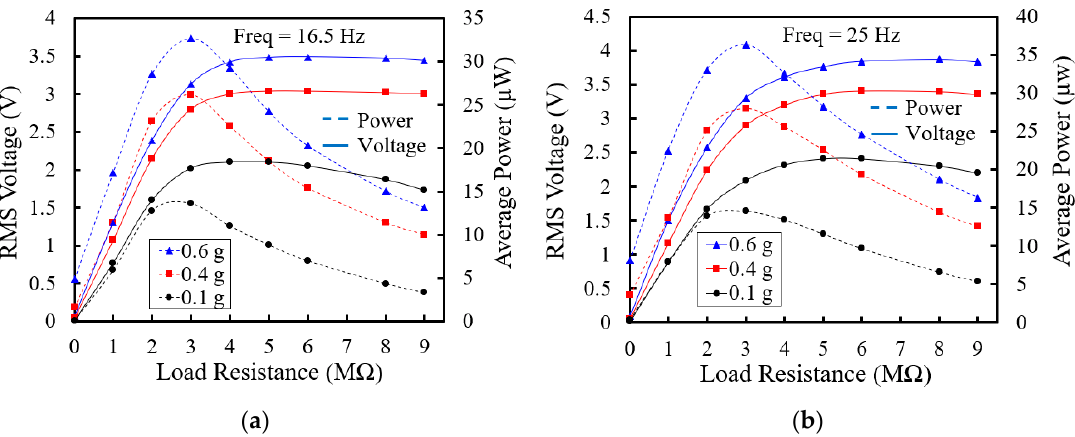
Figure 9. ( a ) Root mean square (RMS) voltage and average power versus load resistance across PVDF-I at 16.5 Hz, under different base accelerations. ( b ) RMS voltage and average power versus load resistance across PVDF-II at 25 Hz, under different base accelerations.